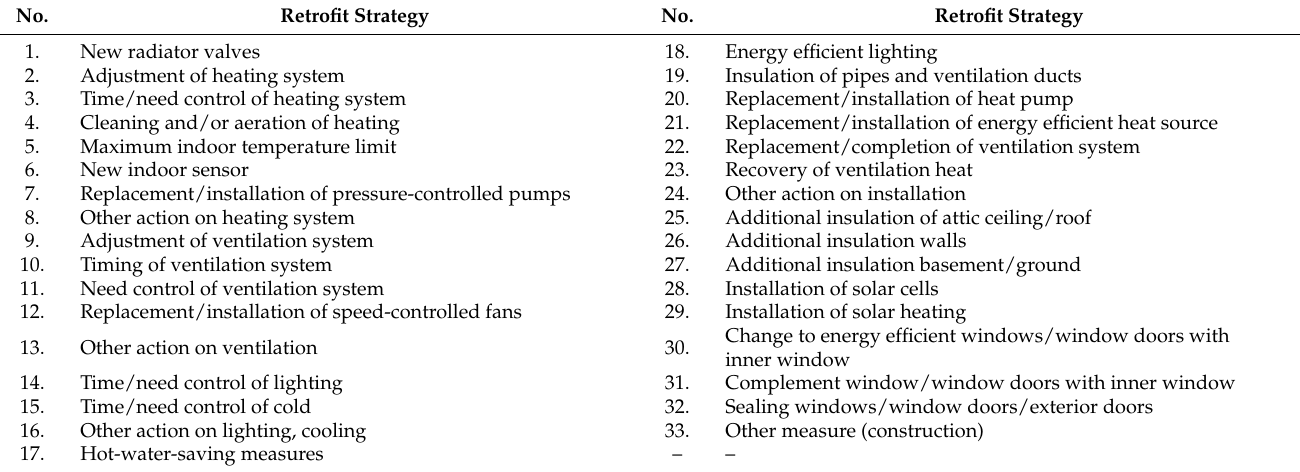
Table 2. The retrofit strategy of an EPC